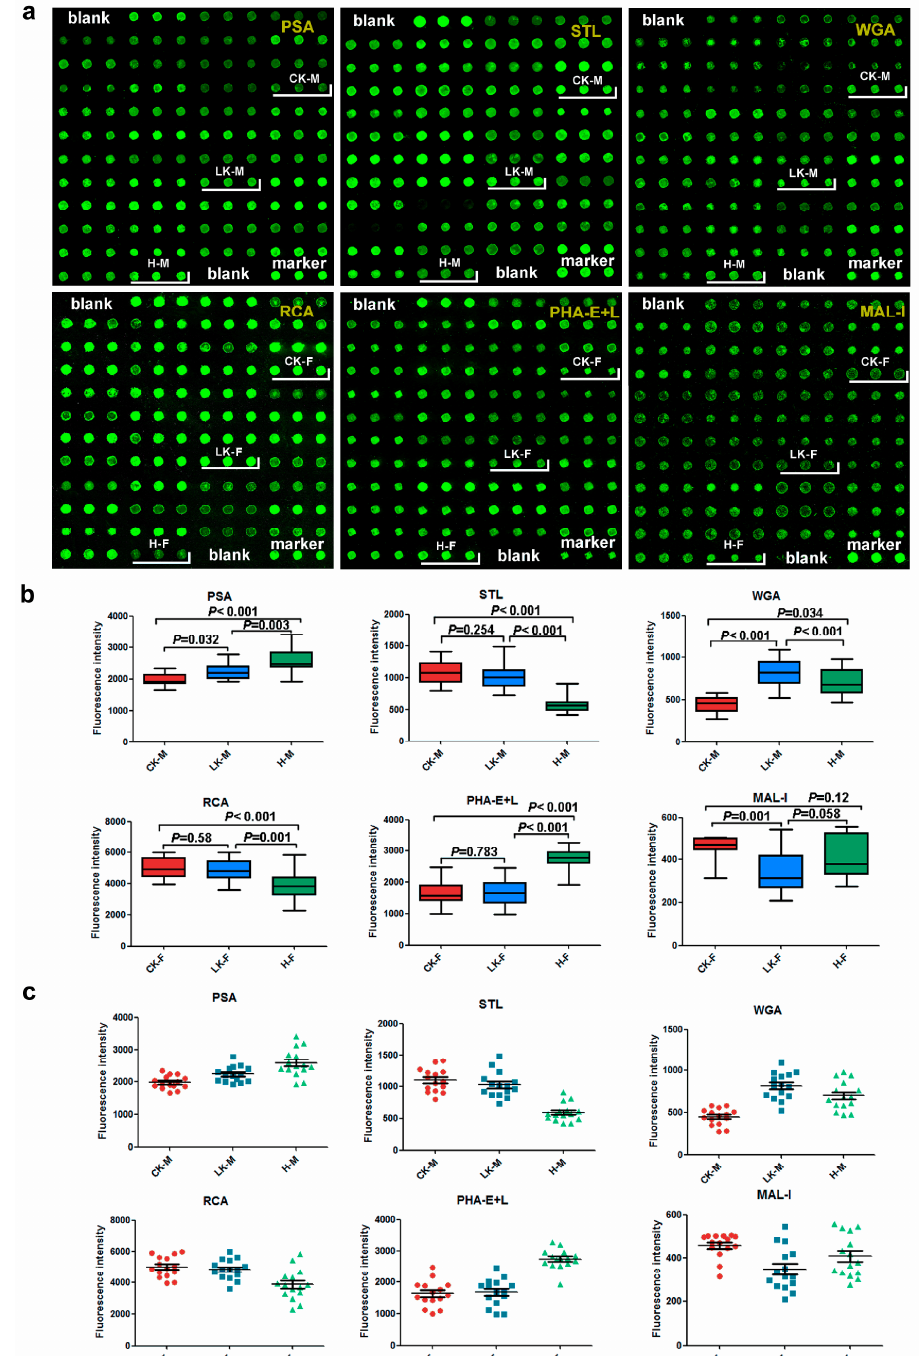
Figure 5. Validation of the binding of 6 lectins (PSA, STL, WGA, RCA, PHA-E+L and MAL-I) to saliva glycoproteins. ( a ) Scanned images of Cy3-labeled lectins bound to the saliva microarrays; ( b ) Box plot analysis of the data for the six groups obtained from the salivary microarray. Error bars represent 95% confidence intervals for mean values. The statistical significance of differences between groups is indicated by the p -value. ( c ) Scatter plot analysis of the data for the six groups obtained from the saliva microarray. Lines represent mean ± SEM. CK-M: male patients with CKD, LK-M: male patients with LKD, H-M: male normal controls, CK-F: female patients with CKD, LK-F: female patients with LKD and H-F.